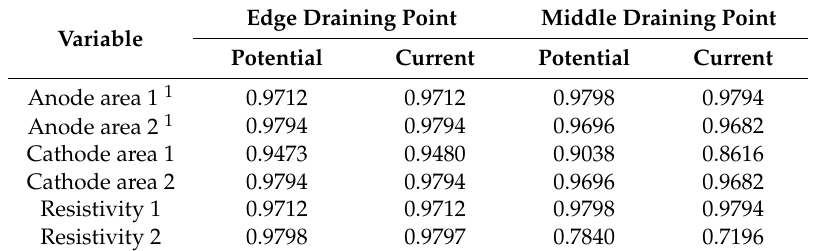
Table 1. Correlation coefficients between experimental and model data for all studied